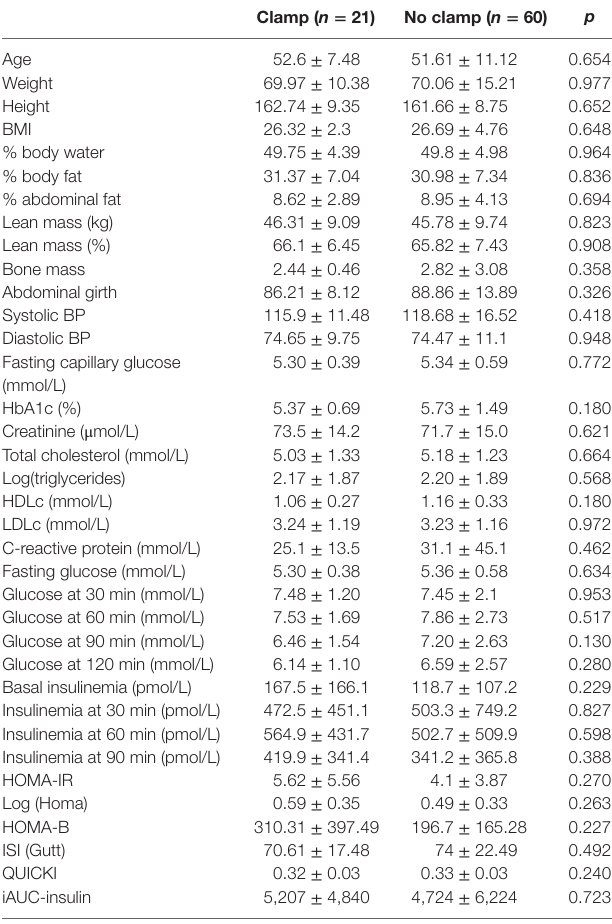
of the iAUCins (Q1 = 169.3, Q4 = 240.6), but this trend did not reach statistical significance ( p -trend = 0.16). Similar to TaBle 3 | Comparison of demographic, clinical, and laboratory characteristics of study participants who underwent or did not undergo the hyperinsulinemic– euglycemic clamp.